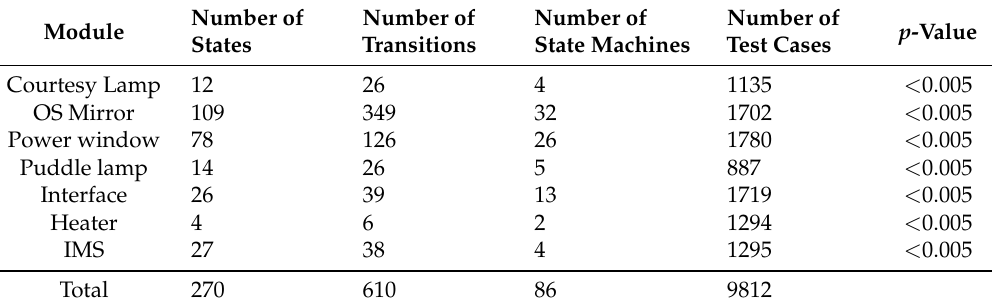
Table 4. Major functionalities of the power-window switch